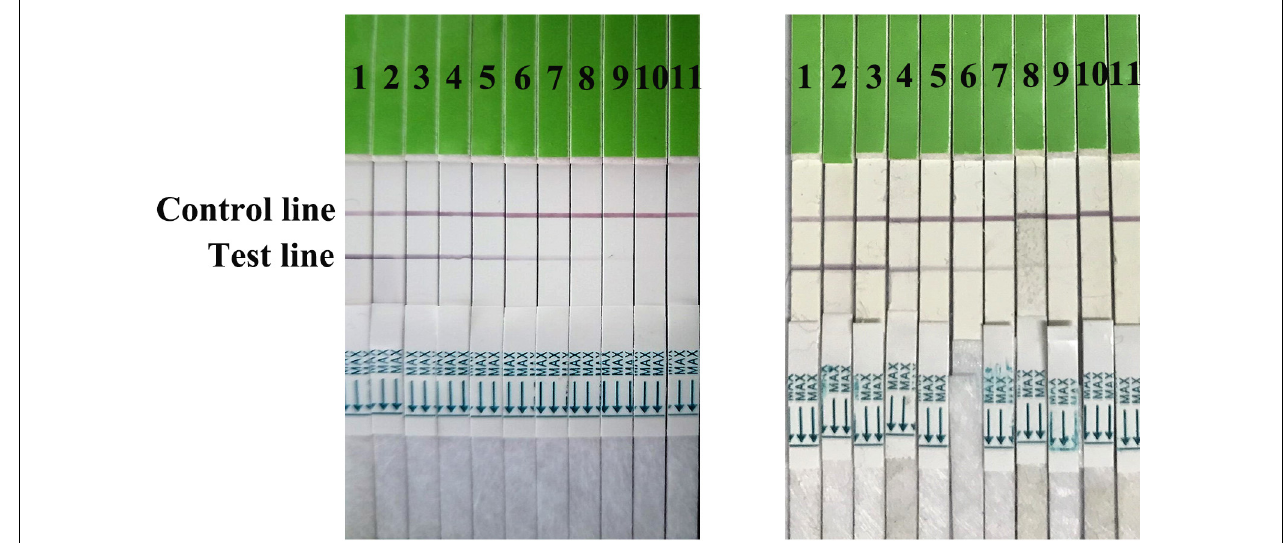
FIGURE 5 | Strip stability. The sensitivities of fresh strips (left) and strips after 12 months of storage (right) were determined. 1: the positive sample. 2–11: diluted ranging from 2 1 to 2 10 .